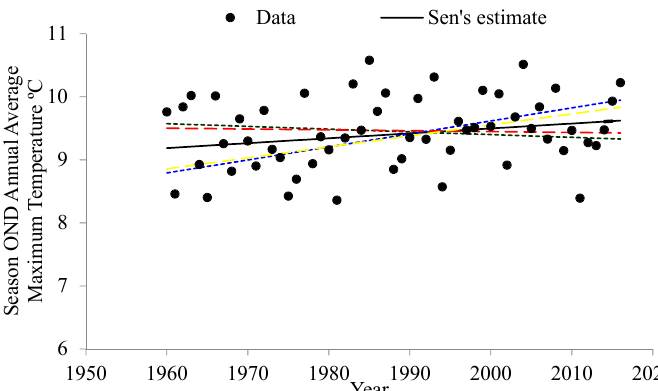
Figure 8. Mann–Kendall and linear regression slopes of annual average minimum temperature for Maloti-Drakensberg for the period of 1960–2016. Atmosphere 2019 , 10 , x FOR PEER REVIEW